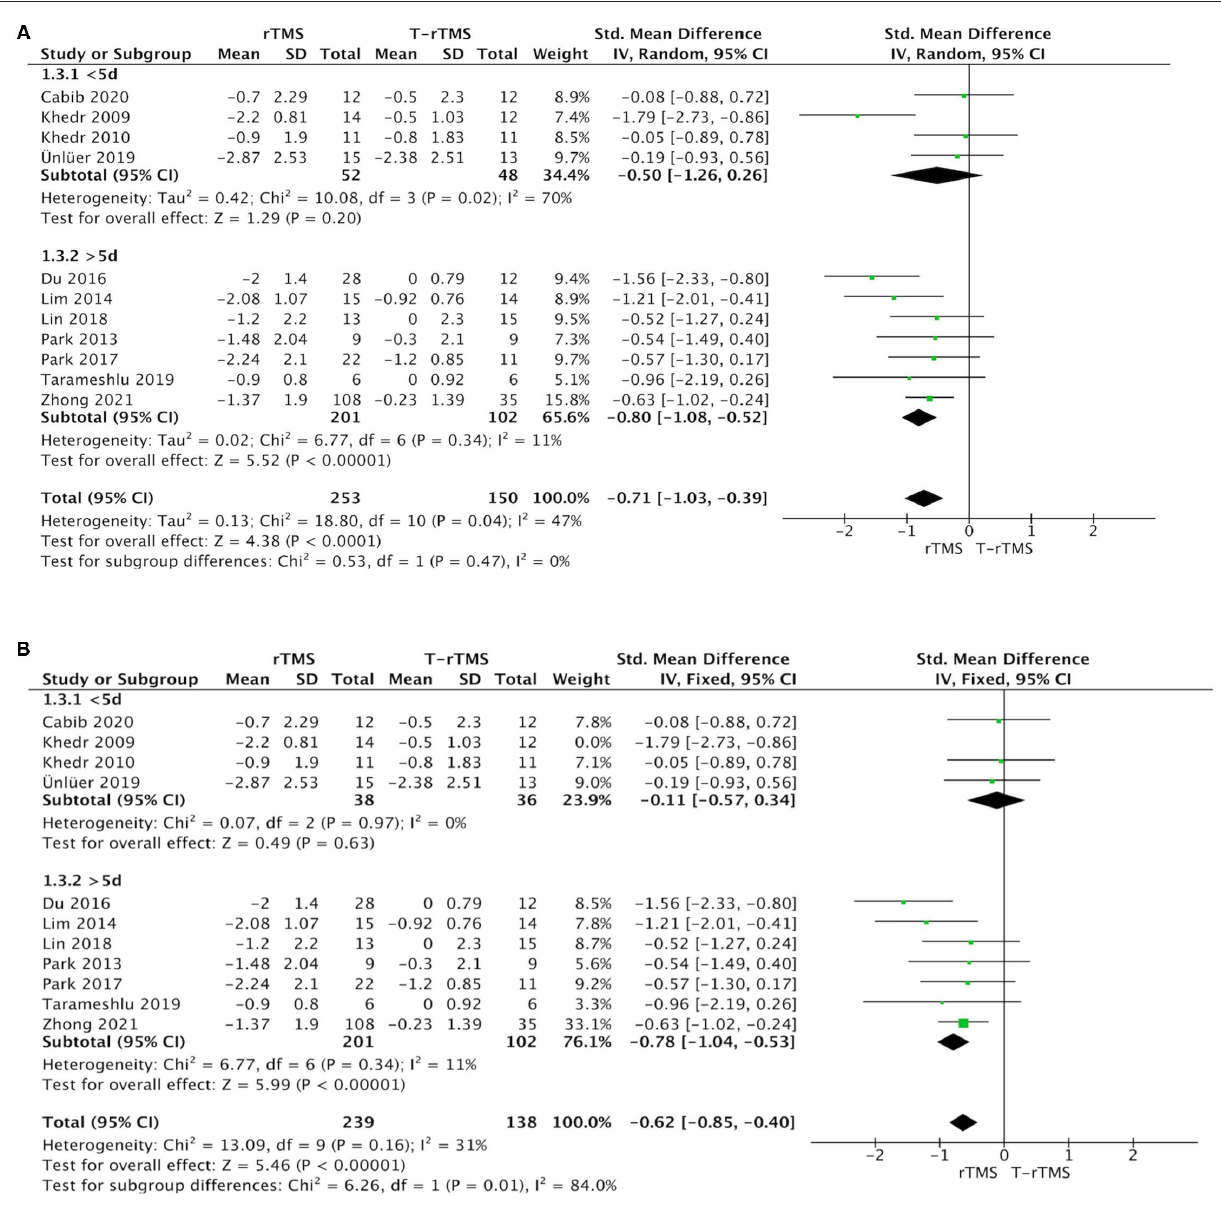
FIGURE 3 | Subgroup analysis of primary outcomes. (A) Forest plot of the standardized mean difference (SMD) for change scores in dysphagia severity rating scales by the treatment duration. (B) Sensitive analysis (excluded the Khedr et al., 2009). PSD, poststroke dysphagia; rTMS, repetitive transcranial magnetic stimulation; T-rTMS, the control group; Mean, Average volume reduction of upper extremities; SD, Sample standard